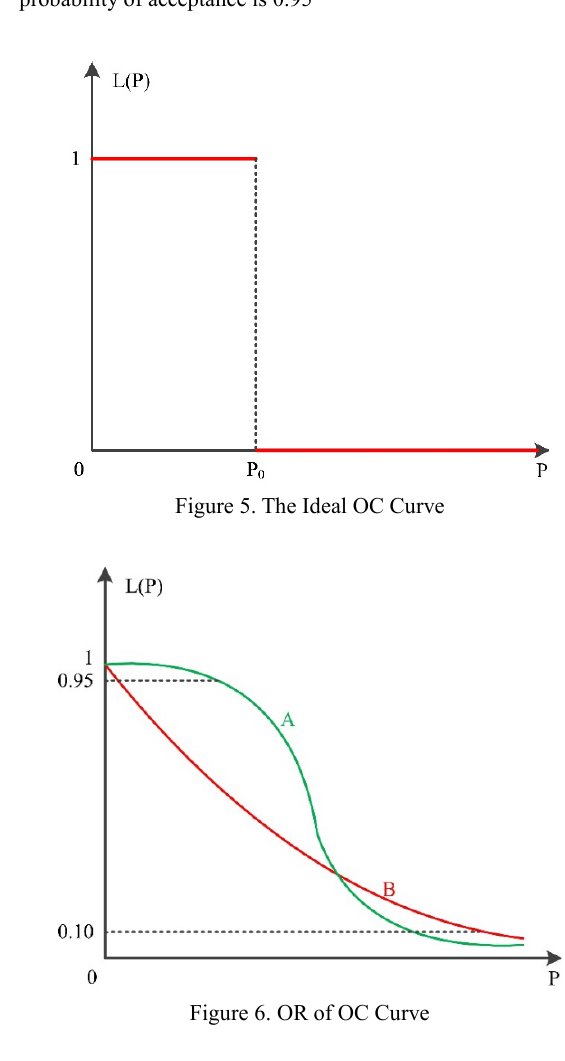
Figure 6. OR of OC